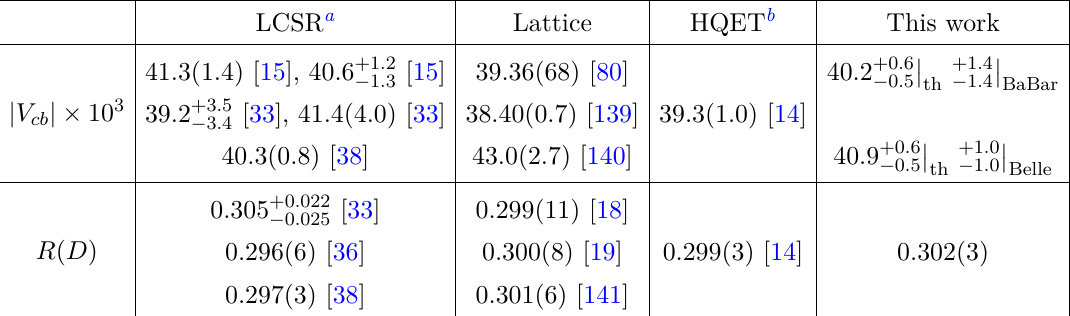
Table 8 . Recent determinations of | V cb | and R ( D ) from different